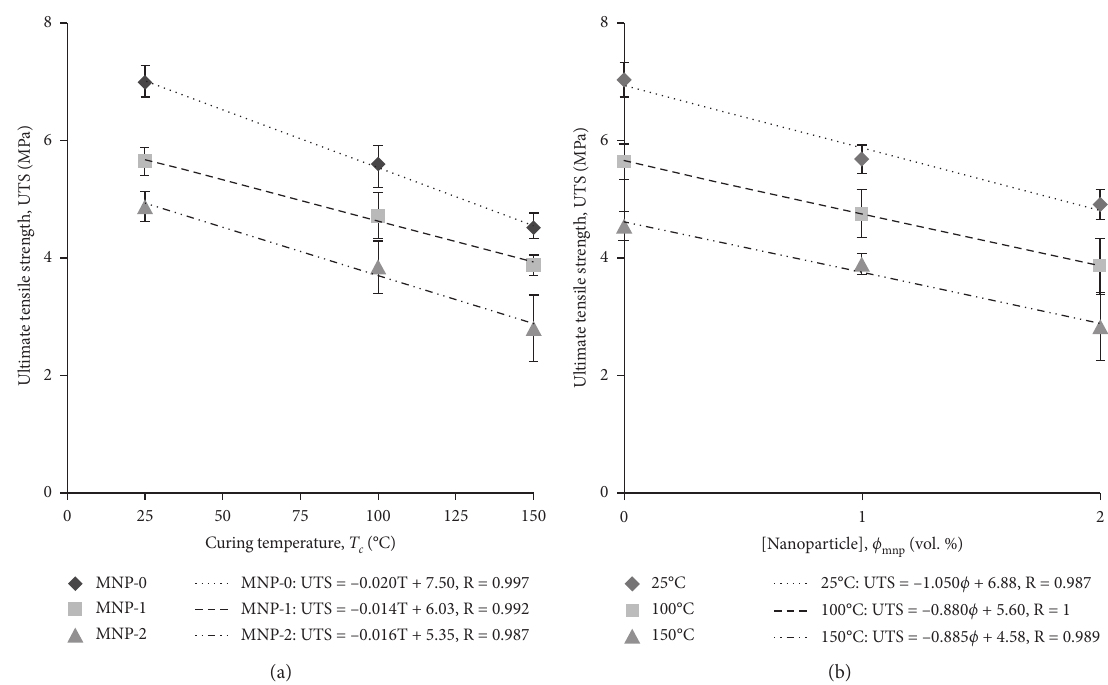
Figure 3: Ultimate tensile strength, UTS, as a function of (a) curing temperature, T at different T . ϕ c mnp